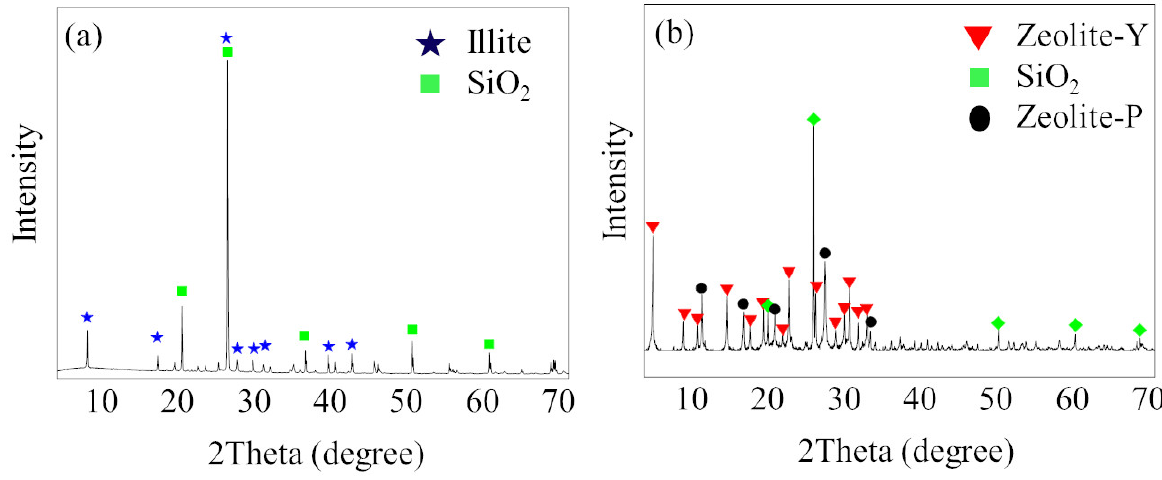
Figure 4. XRD patterns of ( a ) illite and ( b ) ZMA including zeolite-Y, Zeolite-P material.